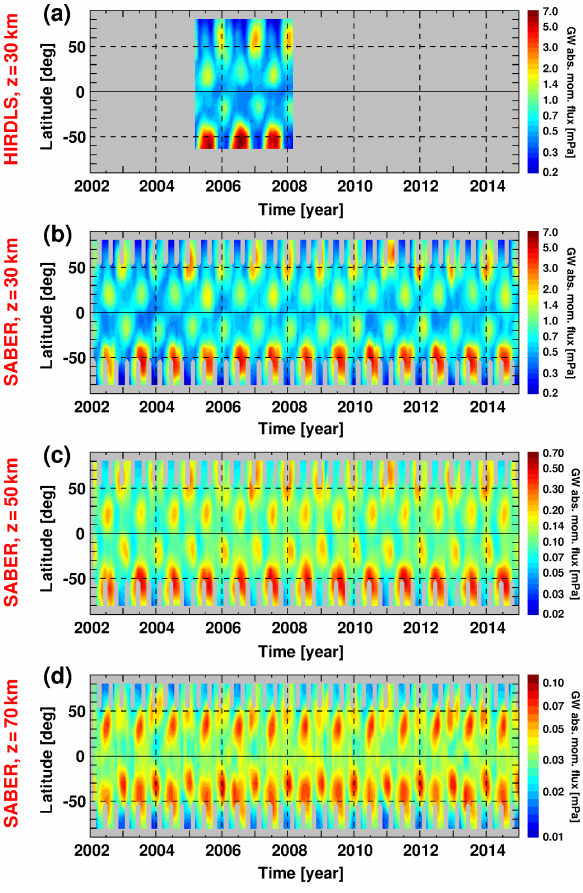
Figure 20. Same as Fig. 19 but for gravity wave potential energy in Jkg − 1 on logarithmic